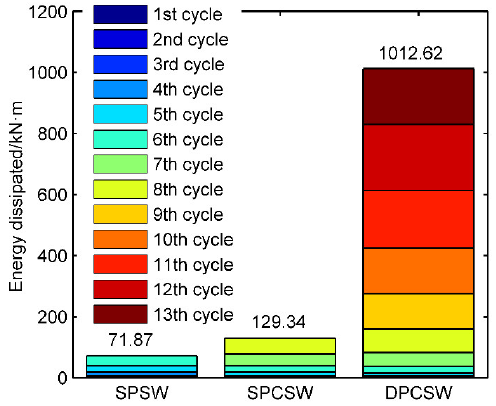
Figure 18. Cumulative energy consumption.